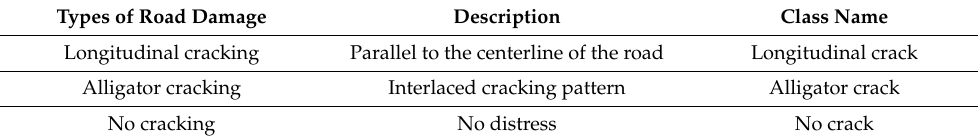
Table 1. Types of road